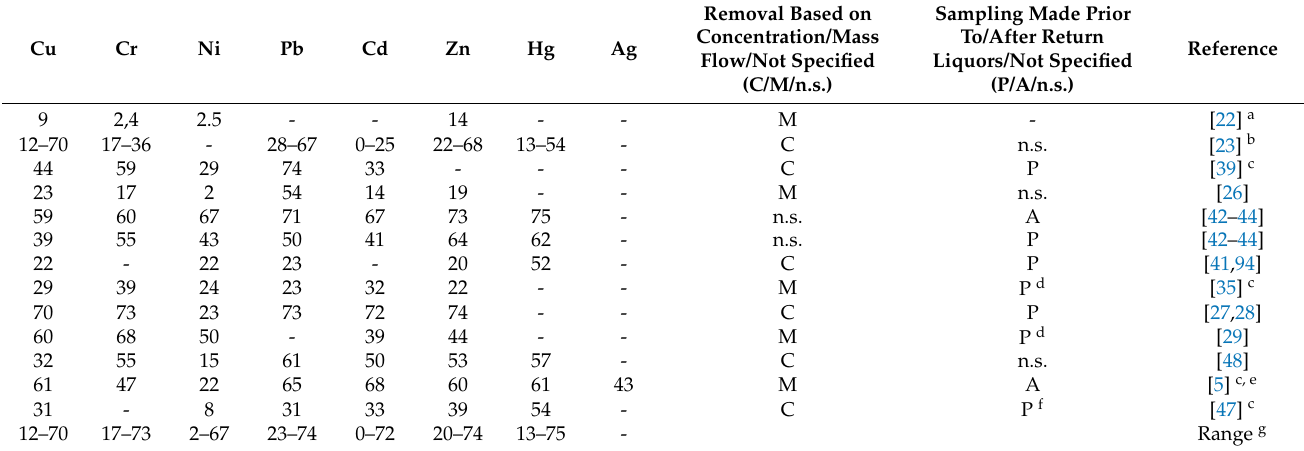
Table 5. Removal of heavy metals during primary settling (%) (data for As not available).